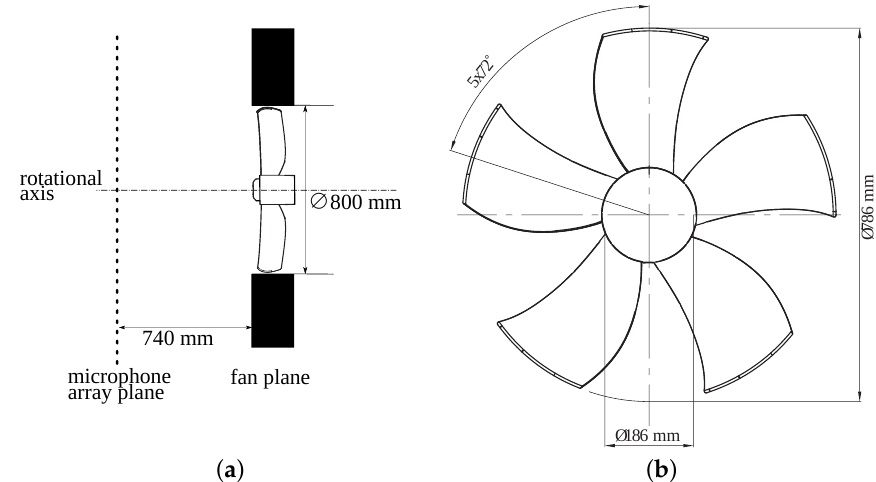
Figure 8. Sketch of the fan measurement setup. ( a ) shows the side view of the setup and ( b ) shows the front view of the